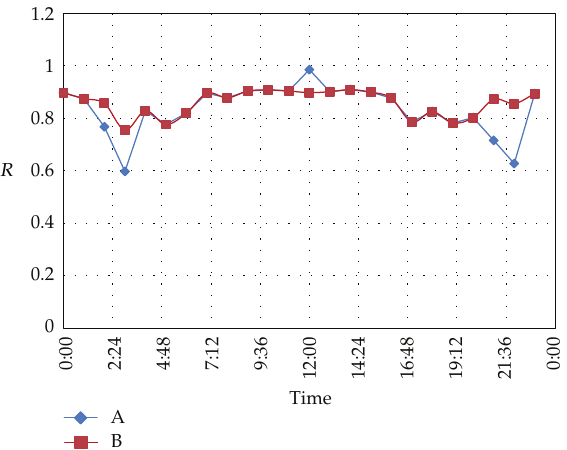
Figure 11: Reliability factor number of the di ff erent